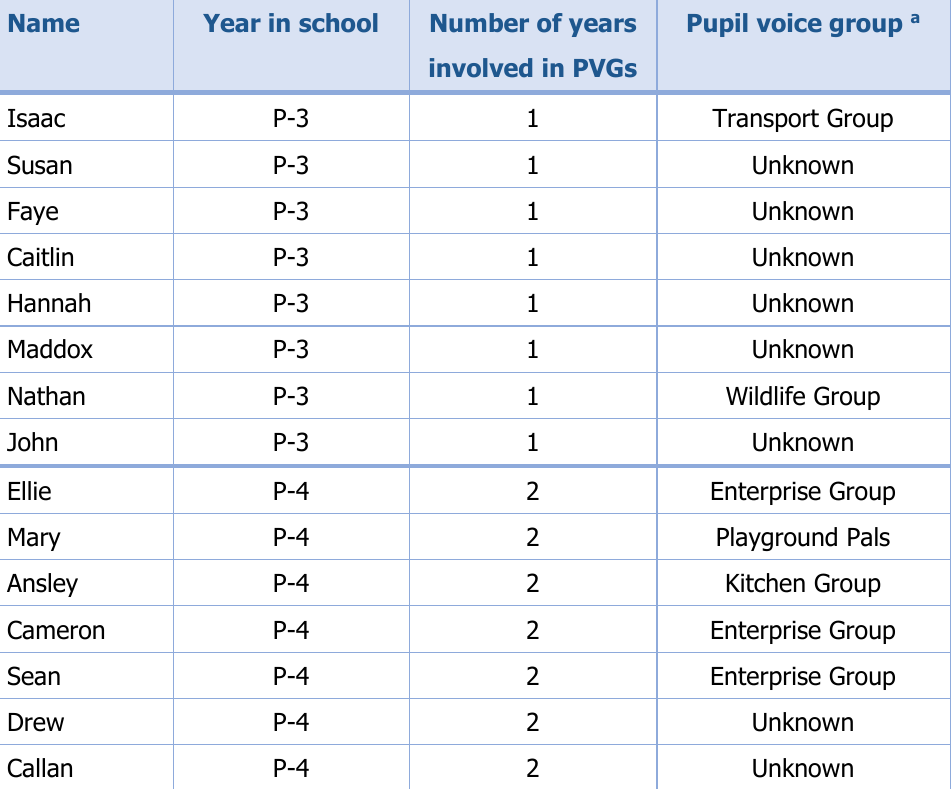
Table 1. Demographics of Participants (n =